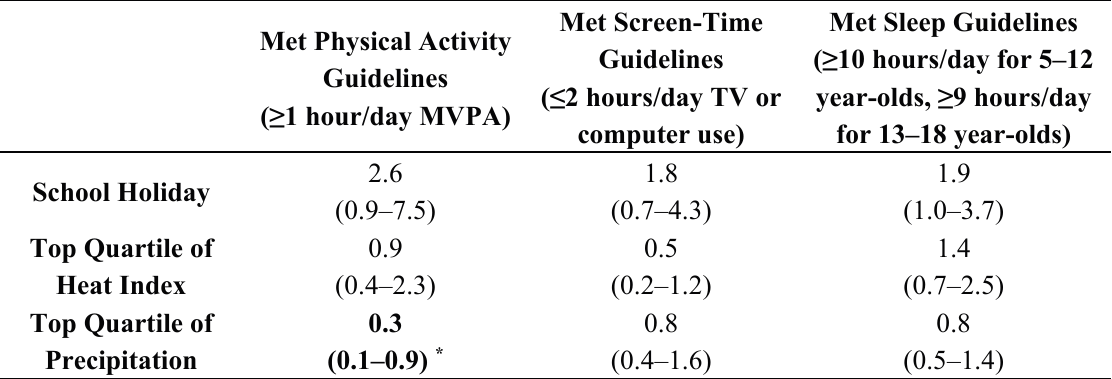
Table 4. Results of logistic regression analyses for likelihood of meeting physical activity, screen-time and sleep guidelines, with being surveyed during school holiday, high heat index and high precipitation. MVPA, moderate to vigorous physical